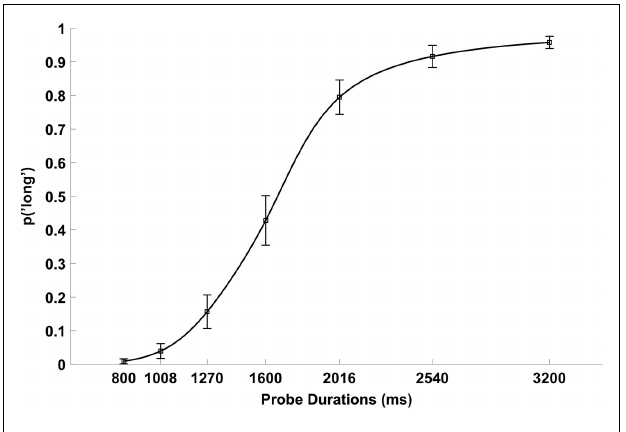
FIGURE 1 | Mean proportion of “long” responses as a function of probe duration averaged across the 12 participants. The error bars indicate 1 SEM.The smooth line illustrates the pseudologistic function (Killeen et al., 1997) fitted to these mean proportions.